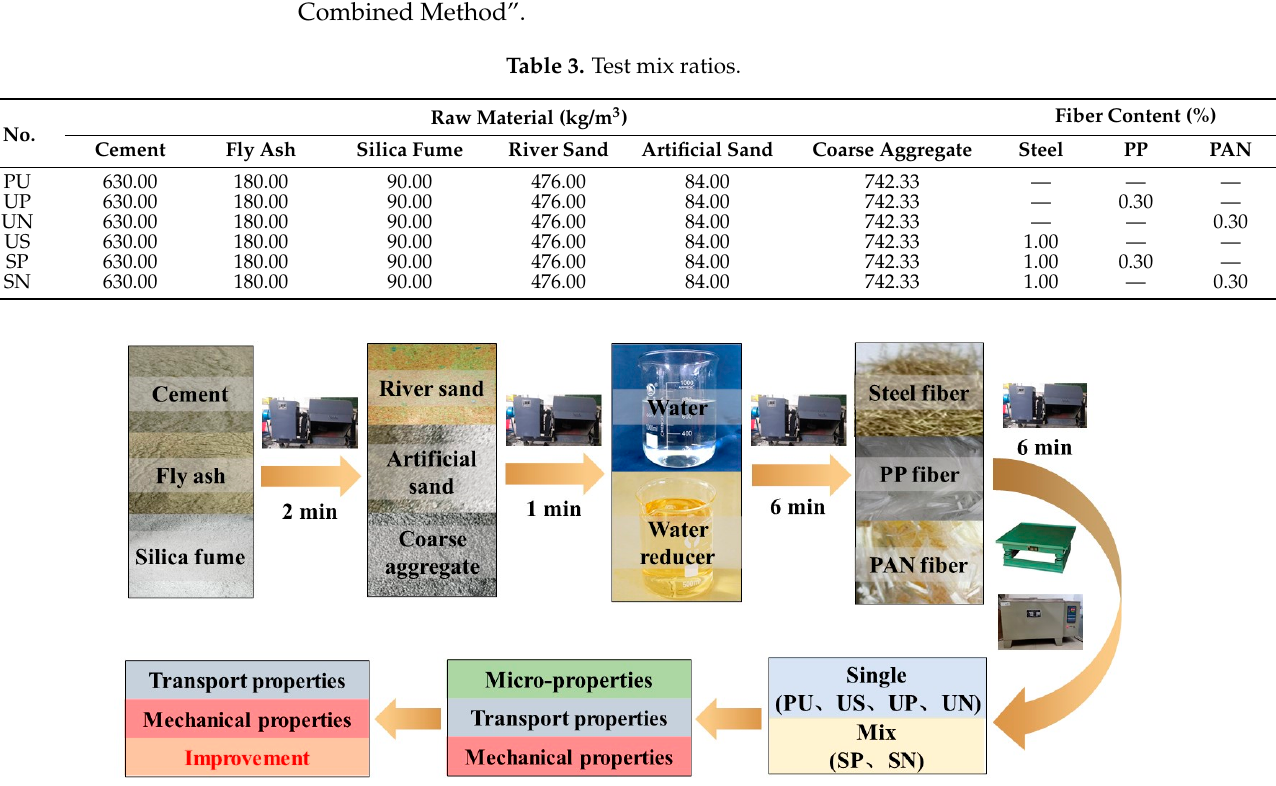
Table 2. Main parameters of the fibers.